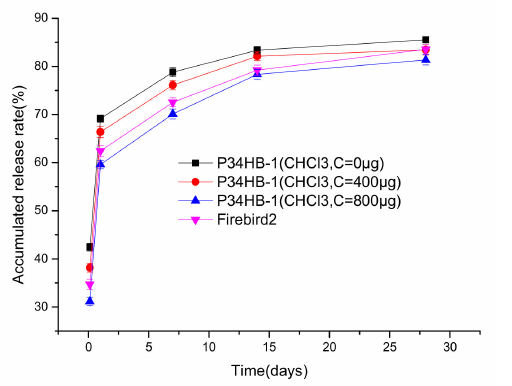
Figure 9. Drug release profiles of P34HB-1 (different outer layer contents) and Firebird2 ®